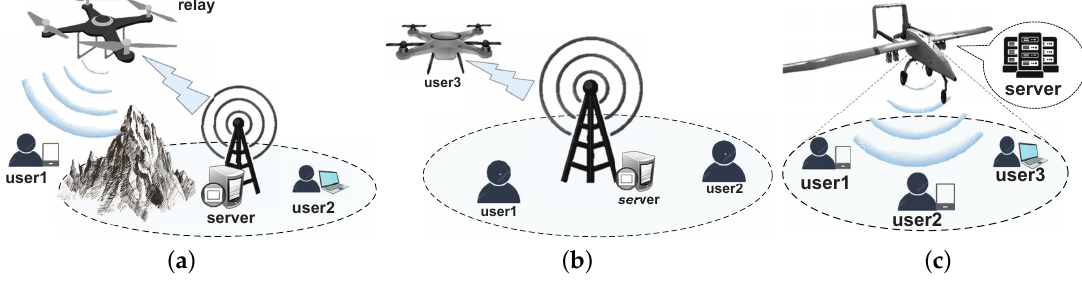
Figure 1. The roles of UAVs in computing resource allocation for MEC networks. ( a ) uav as relay. ( b ) uav as user. ( c ) uav as